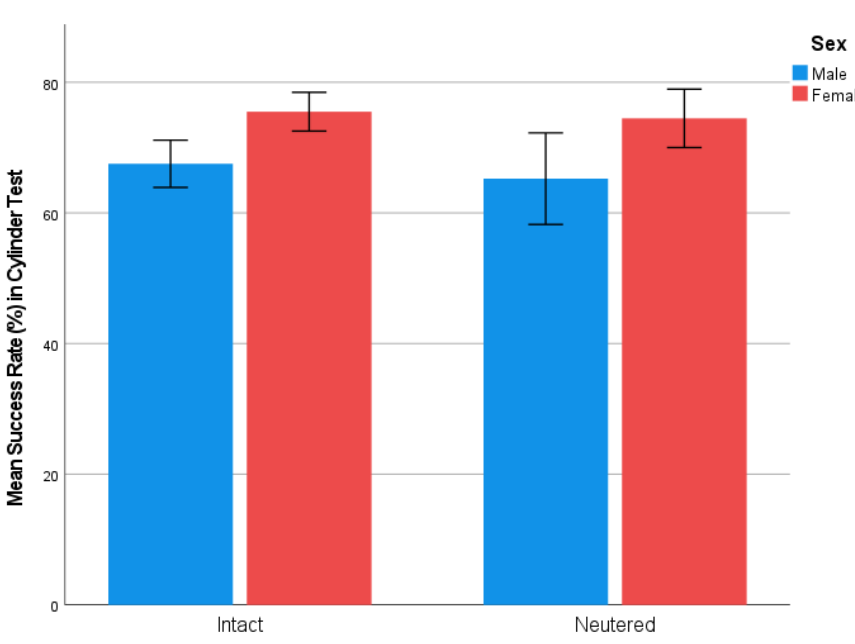
Figure 4. Mean success rates (%) of intact males ( n = 189), intact females ( n = 197), neutered males ( n = 61), and neutered ( n = 92 ) in the cylinder test (95% confidence interval).